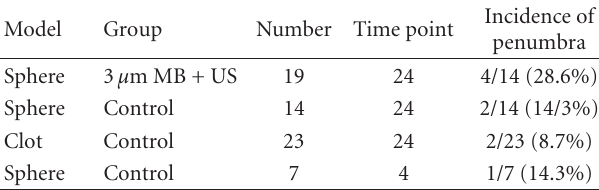
Table 1: Incidence of